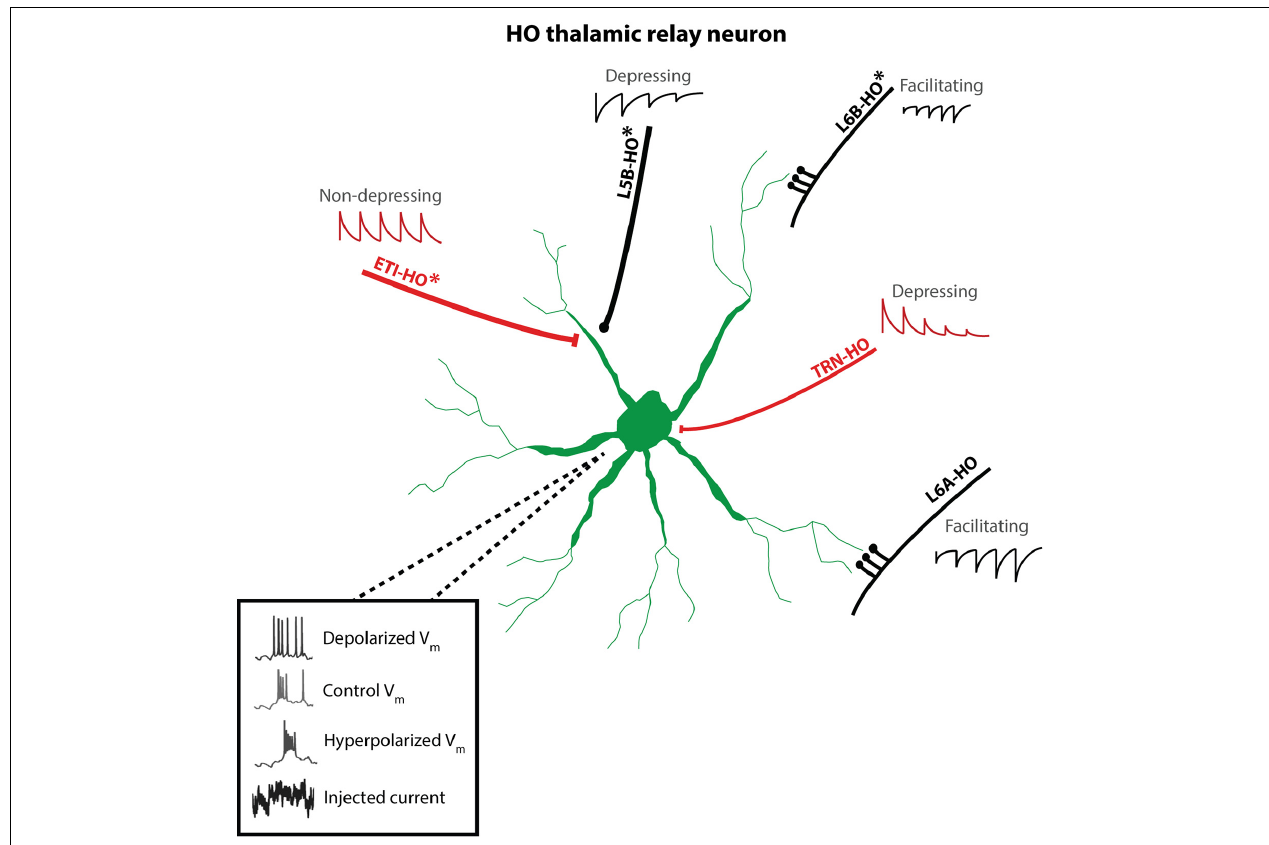
FIGURE 2 | Cartoon of synaptic inputs to HO thalamic relay neurons and intrinsic excitability patterns. Asterisks (*) indicate inputs which target HO thalamus and are not present in FO nuclei. L5tt neurons provide strong, depressing “driving” excitatory input to proximal dendrites via large synapses, while L6A CT en passant synapses provide relatively weaker, facilitating, modulatory excitatory input to distal dendrites. L6B provides en passant excitatory inputs (synaptic dynamics not yet reported). Inhibitory TRN inputs show strong depression. In contrast, powerful inhibitory ETI synapses are located in close proximity to L5tt excitatory inputs and show little depression. Not shown: additional area-specific sources of driver input reported in “convergence” zones of HO thalamus and feedforward inhibitory loops L5tt-ETI-thalamus and L6A-TRN-thalamus. Inset voltage traces: HO thalamic neurons show characteristic voltage-dependent bursting: depolarization inactivates bursting mechanisms and promotes tonic